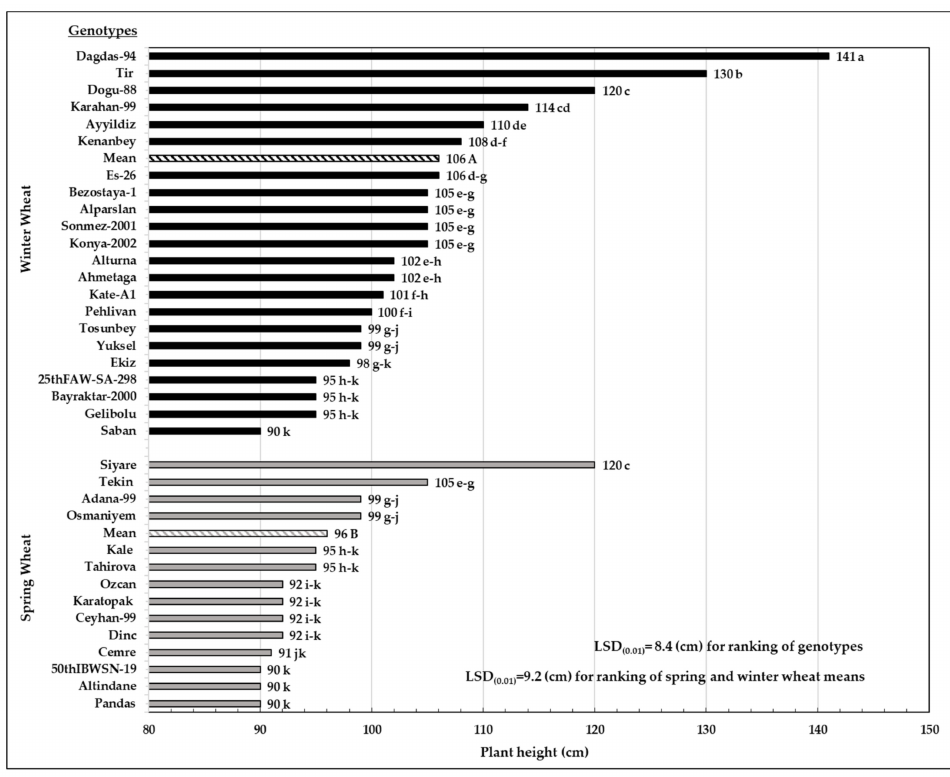
Figure 6. Comparing winter wheat genotypes with spring wheat genotypes for plant height (cm) over two cropping seasons. Genotypes with the same letter are not significantly